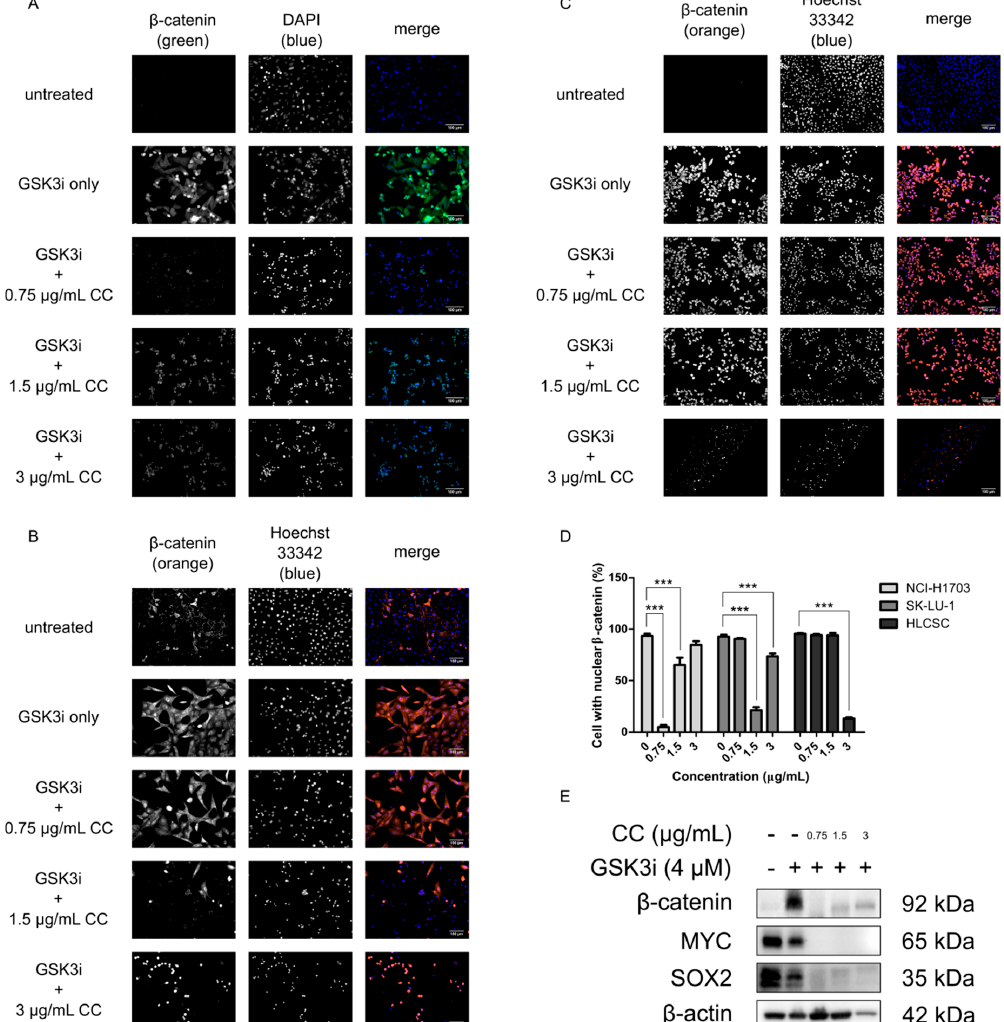
Figure 2. Molecular implications of chelerythrine chloride treatment in lung cancer cell lines. NCI ‐ H1703, SK ‐ LU ‐ 1, and HLCSC were treated with GSK3i for 24 h and sequentially treated with various